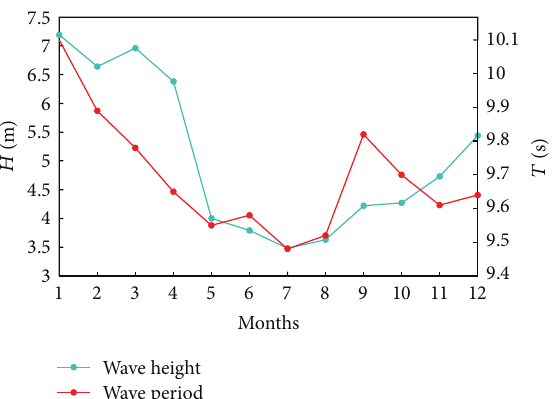
Figure 3: Analysis of the wave data measured at a buoy close to the target area in the period 2006–2011: 𝐻 (m) monthly maximum wave height; 𝑇 (s) monthly maximum wave period.